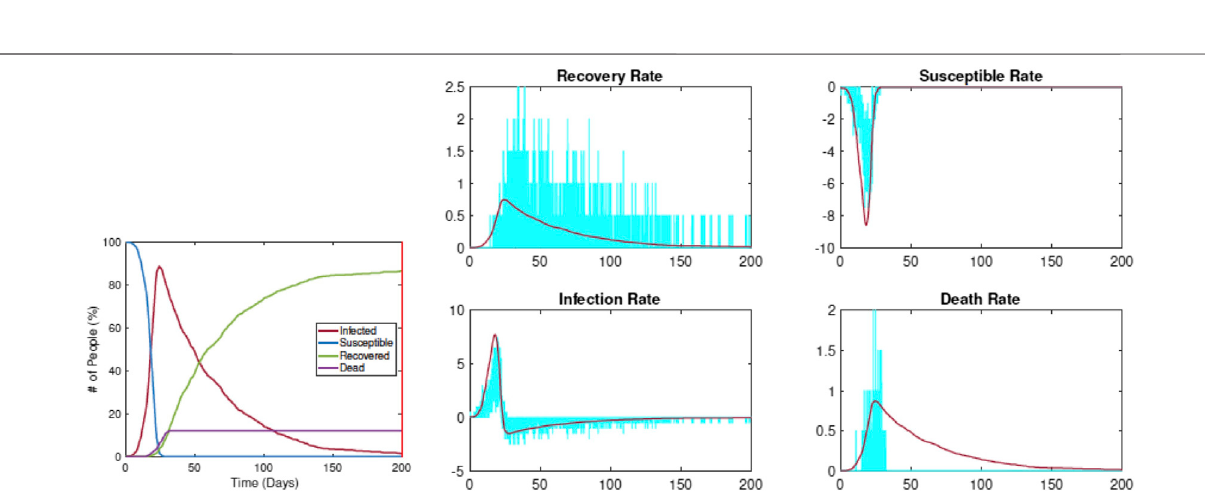
Frontiers in Applied Mathematics and Statistics |